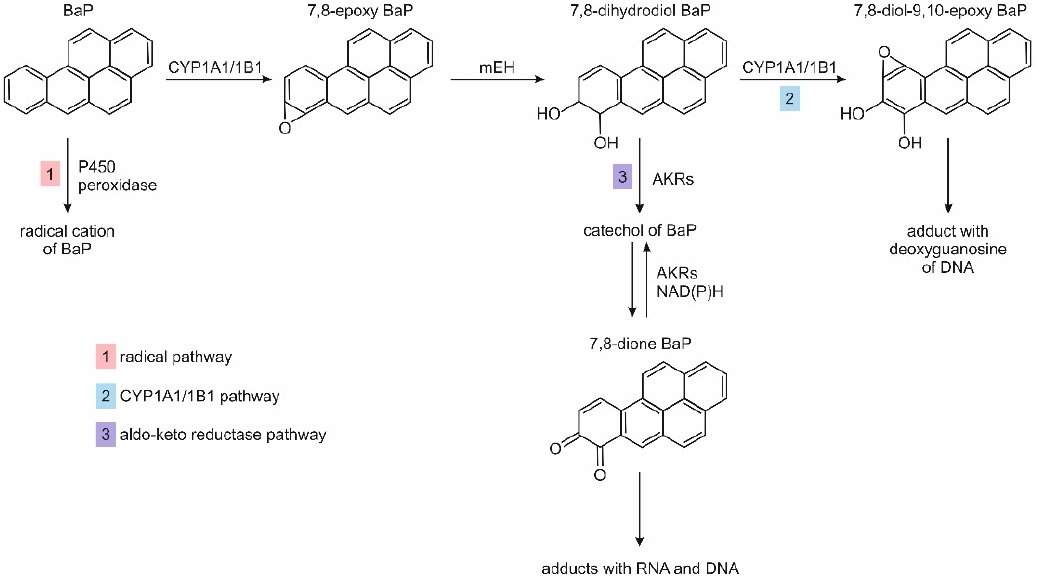
Figure 2. PAH metabolism pathway BaP based on references [44,45]. Abbreviations: CYP—cyto- chrome P450; mEH—microsomal epoxide hydrolase; AKRs—aldo-keto reductases; NAD(P)H— quinone oxidoreductase.